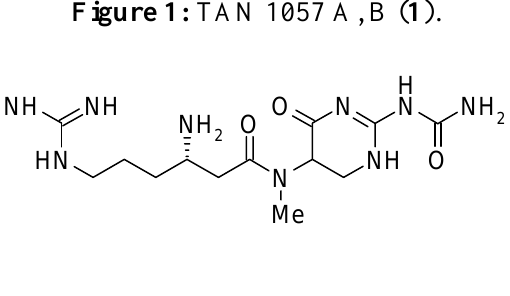
Figure 1: TAN 1057 A, B ( 1 ).